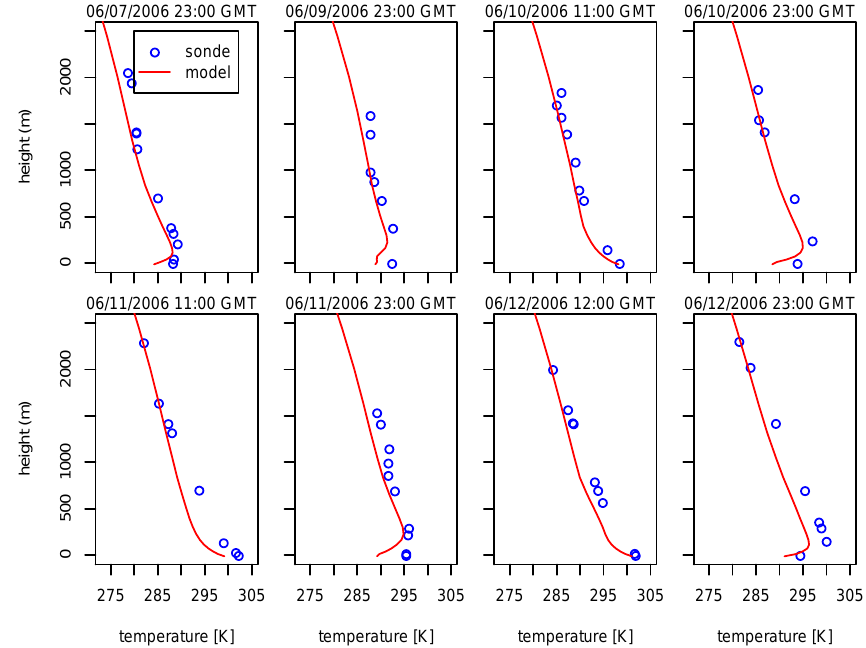
Fig. 4. Comparison between radio soundings and model output (base run) at Trappes during the selected 5-day period of clear-sky conditions